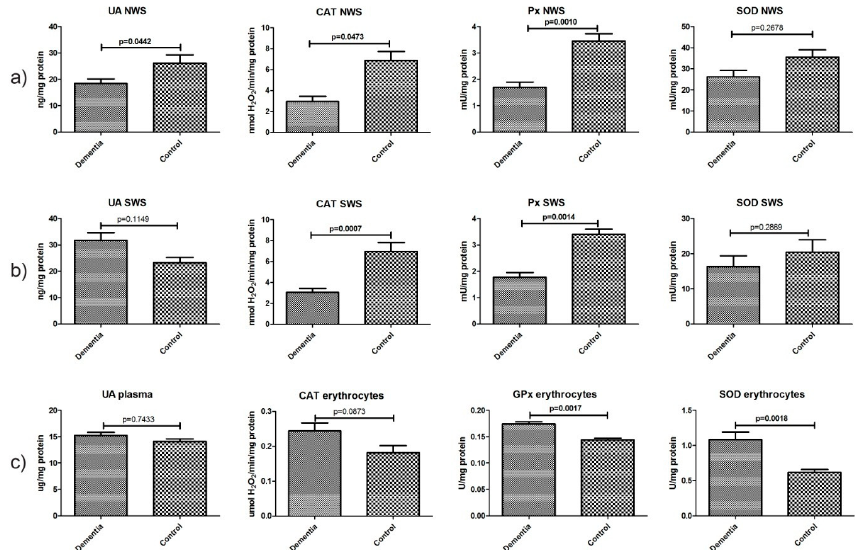
Figure 2. Non-enzymatic and enzymatic antioxidants in non-stimulated ( a ) and stimulated ( b ) saliva as well as plasma/erythrocytes ( c ) of dementia patients and the control group. Abbreviations: CAT, catalase; NWS, non-stimulated whole saliva; Px, salivary peroxidase; GPx, glutathione peroxidase; SOD, superoxide dismutase-1; SWS, stimulated whole saliva, UA, uric acid.